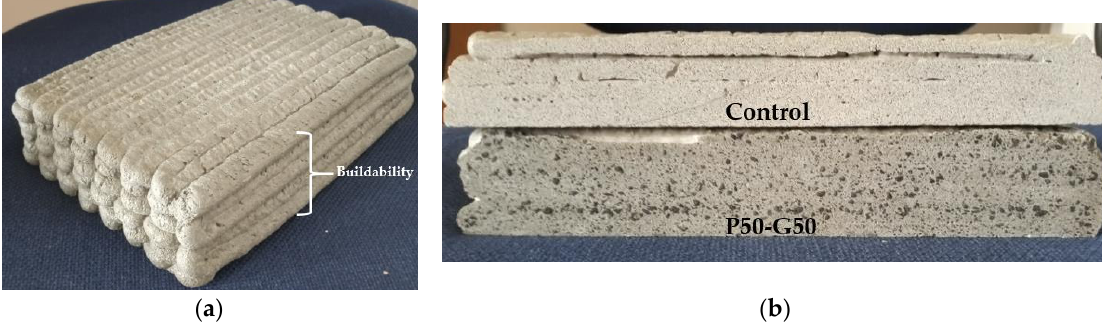
Figure 7. Proper buildability in the P50-G50 sample ( a ) and visual inspection of inter-layer adhesion in the control and P50-G50 mixes ( b ).